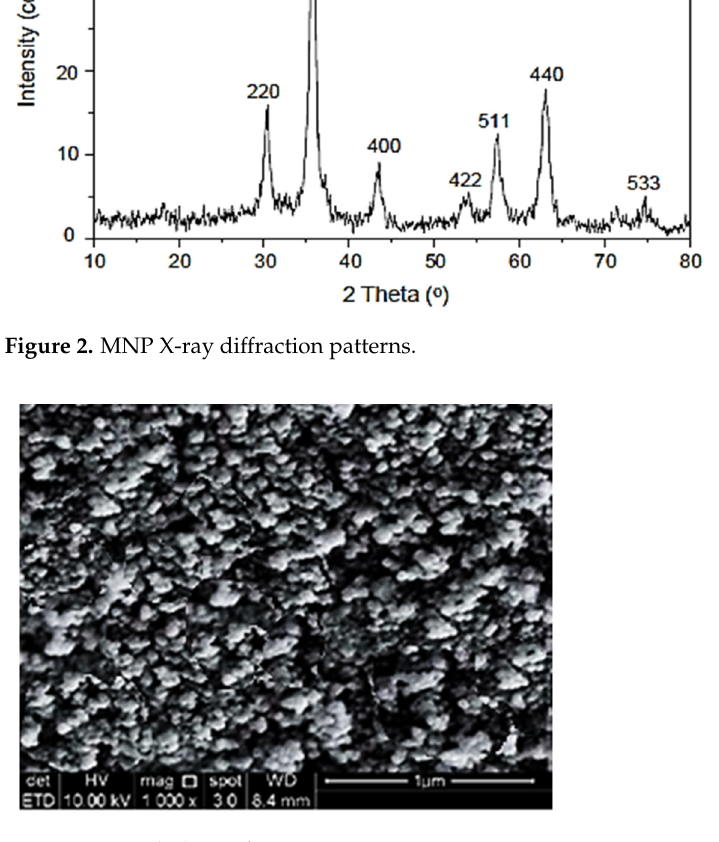
Figure 3. Morphology of pure MNP.